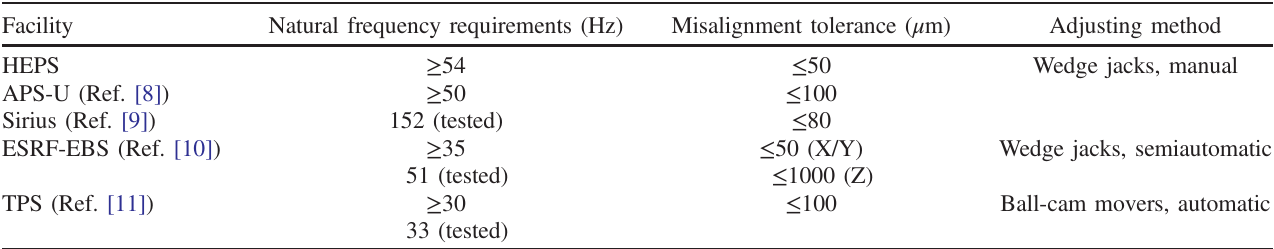
TABLE I. Requirements on magnet girders of some new-designed or updated photon sources.